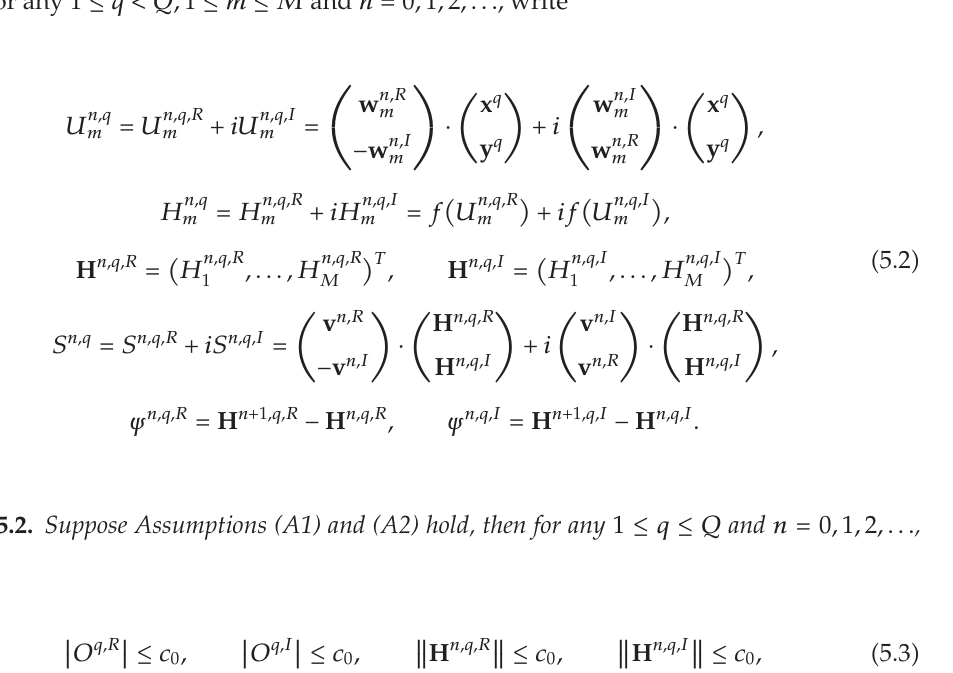
For any 1 ≤ q < Q, 1 ≤ m ≤ M and n (cid:7) 0 , 1 , 2 , . . . ,